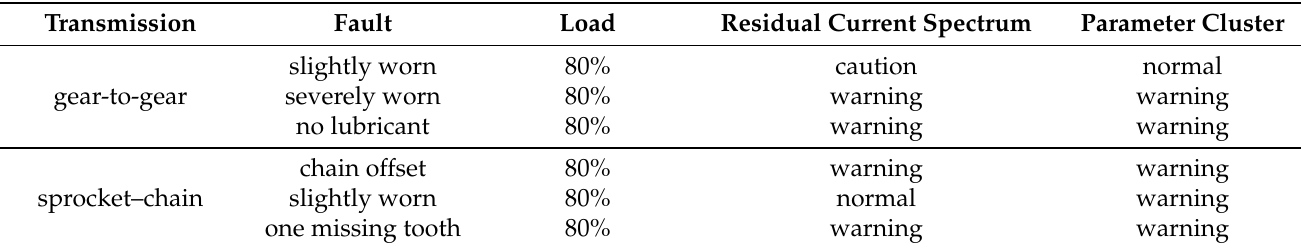
Table 4. The summary of gear-to-gear and sprocket–chain transmissions FDI results using residual current spectrum threshold and parameter